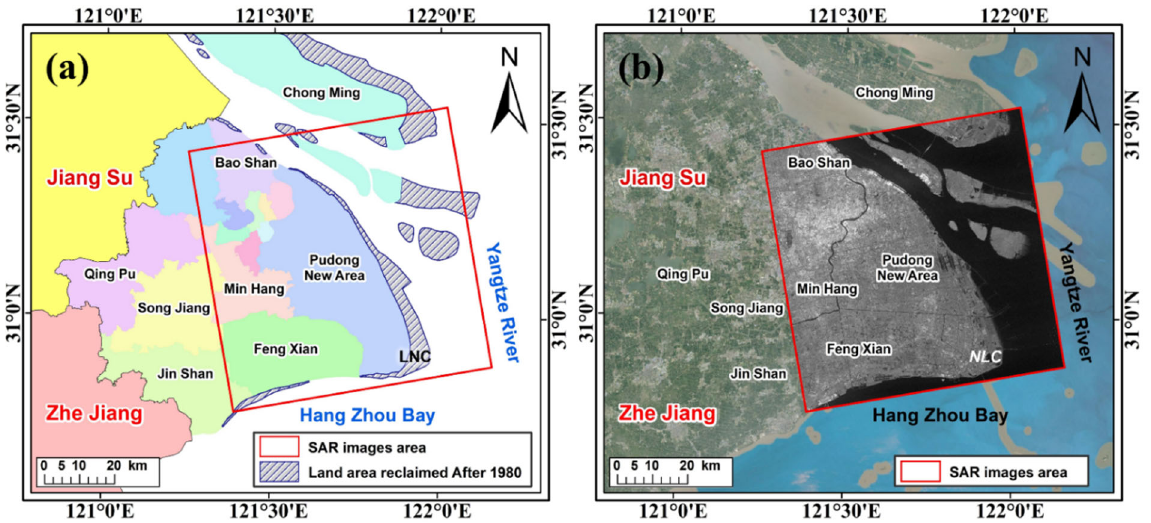
Figure 1. Location of the study area; ( a ) The red outline shows the SAR image coverage area of Sentinel ‐ 1A, and the colored plate shows the administrative division near Shanghai; ( b ) the red outline displays Sentinel ‐ 1A SAR images.